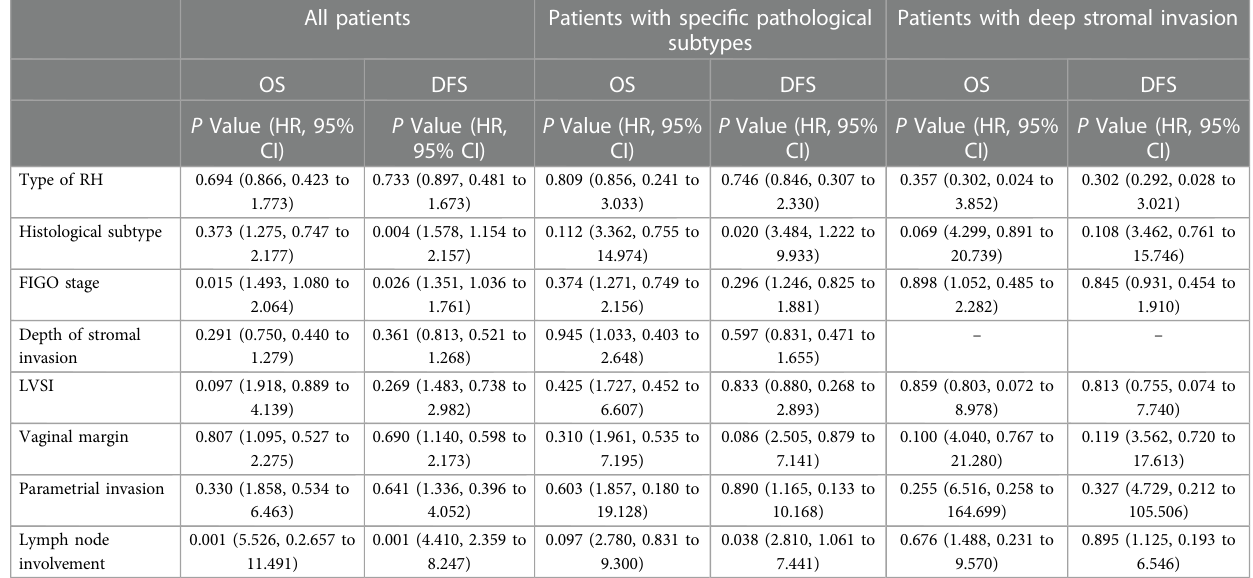
TABLE 3 Cox regression of the included cervical cancer